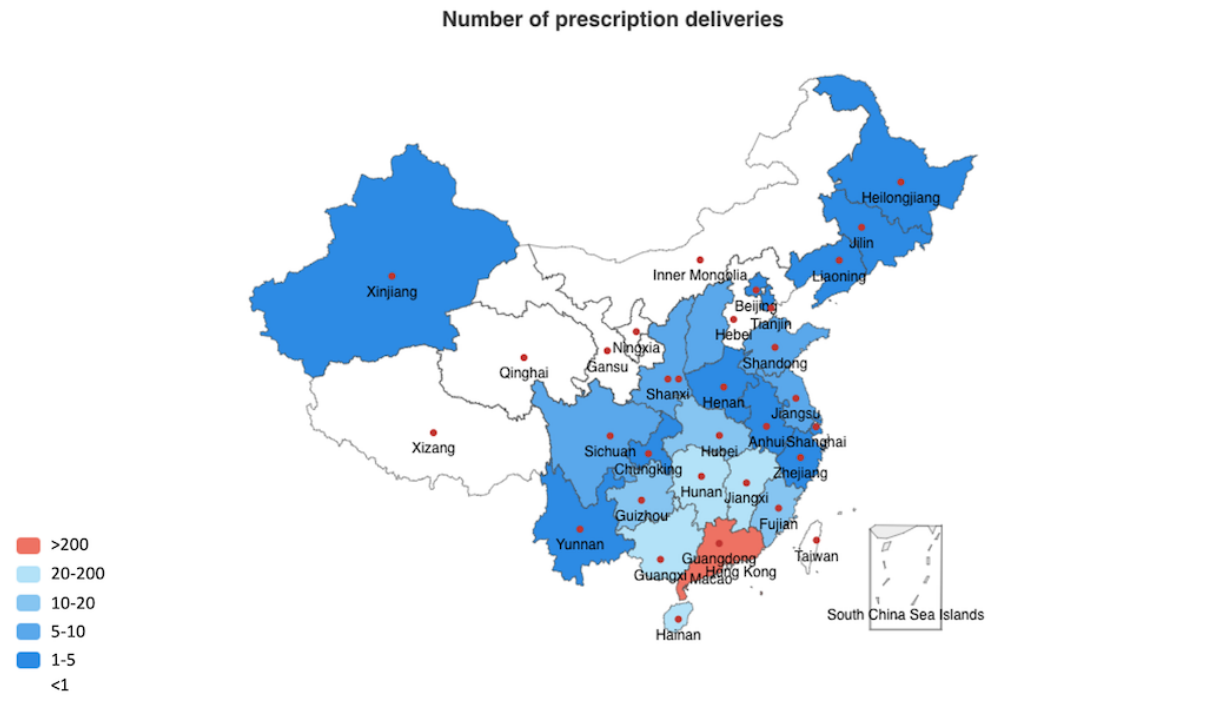
Figure 5. Regional distribution of prescription deliveries via the Cloud SYSUCC app